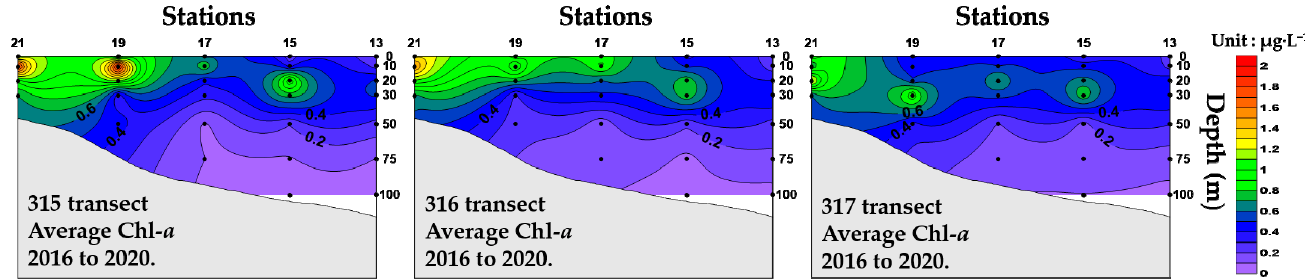
Figure 8. Vertical distributions of the average chl- a concentrations (µg·L − 1 ) in the northern East China Sea from 2016 to 2020. Table 3. Vertical variation of the chl- a size composition in the northern East China Sea from 2016 to